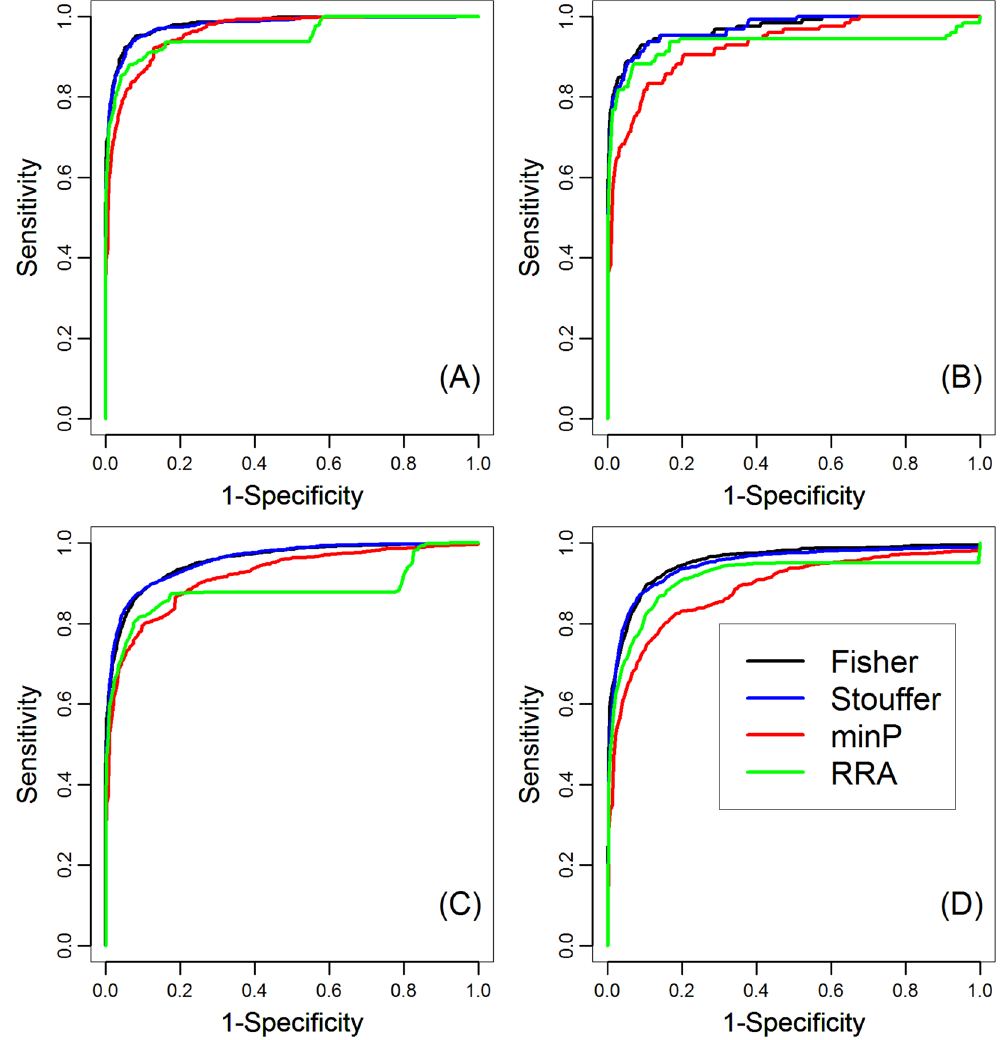
Figure 5. ROC curves of different data fusion strategies. Rank ROCs of four different data fusion strategies for ( A ) nonframeshift deletion; ( B ) nonframeshift insertion; ( C ) frameshift deletion; ( D ) frameshift